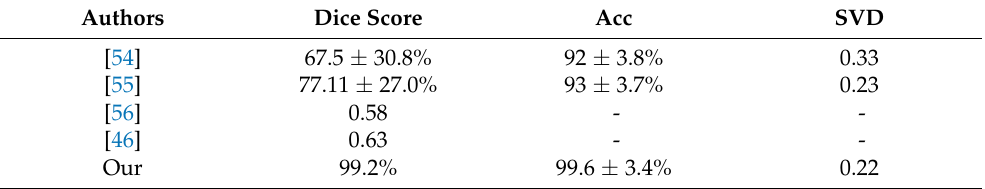
Table 3. Segmented results of proposed framework represented as mean ± standard